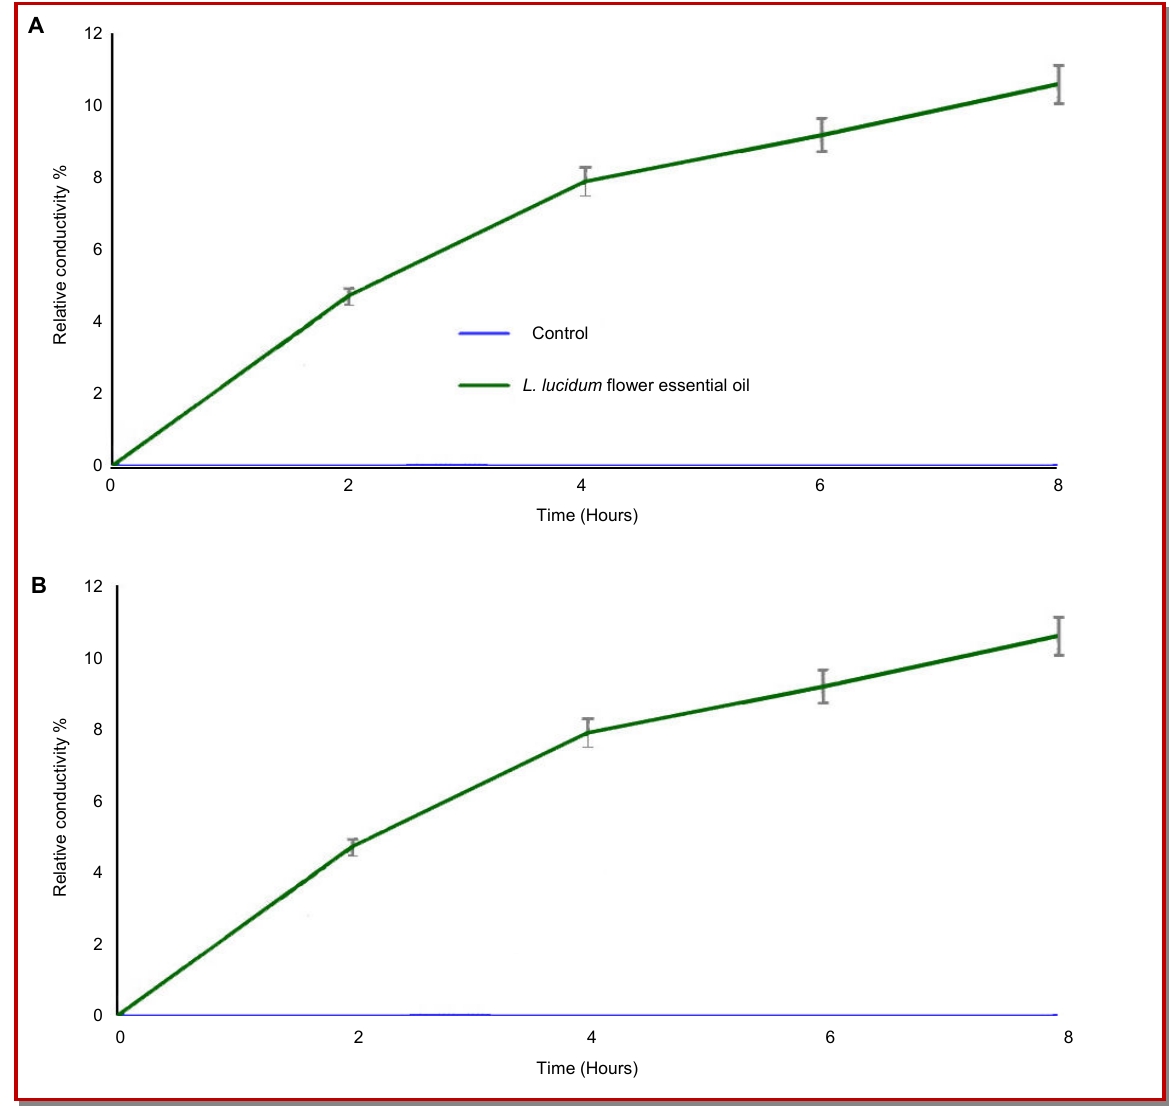
Figure 5: Effect offlower essential oil of Ligustrum lucidum on membrane permeability of S. aureus KCTC-1621 (A) and S. enterica ATCC-4731 (B). Data are expressed as mean ± SD (n =